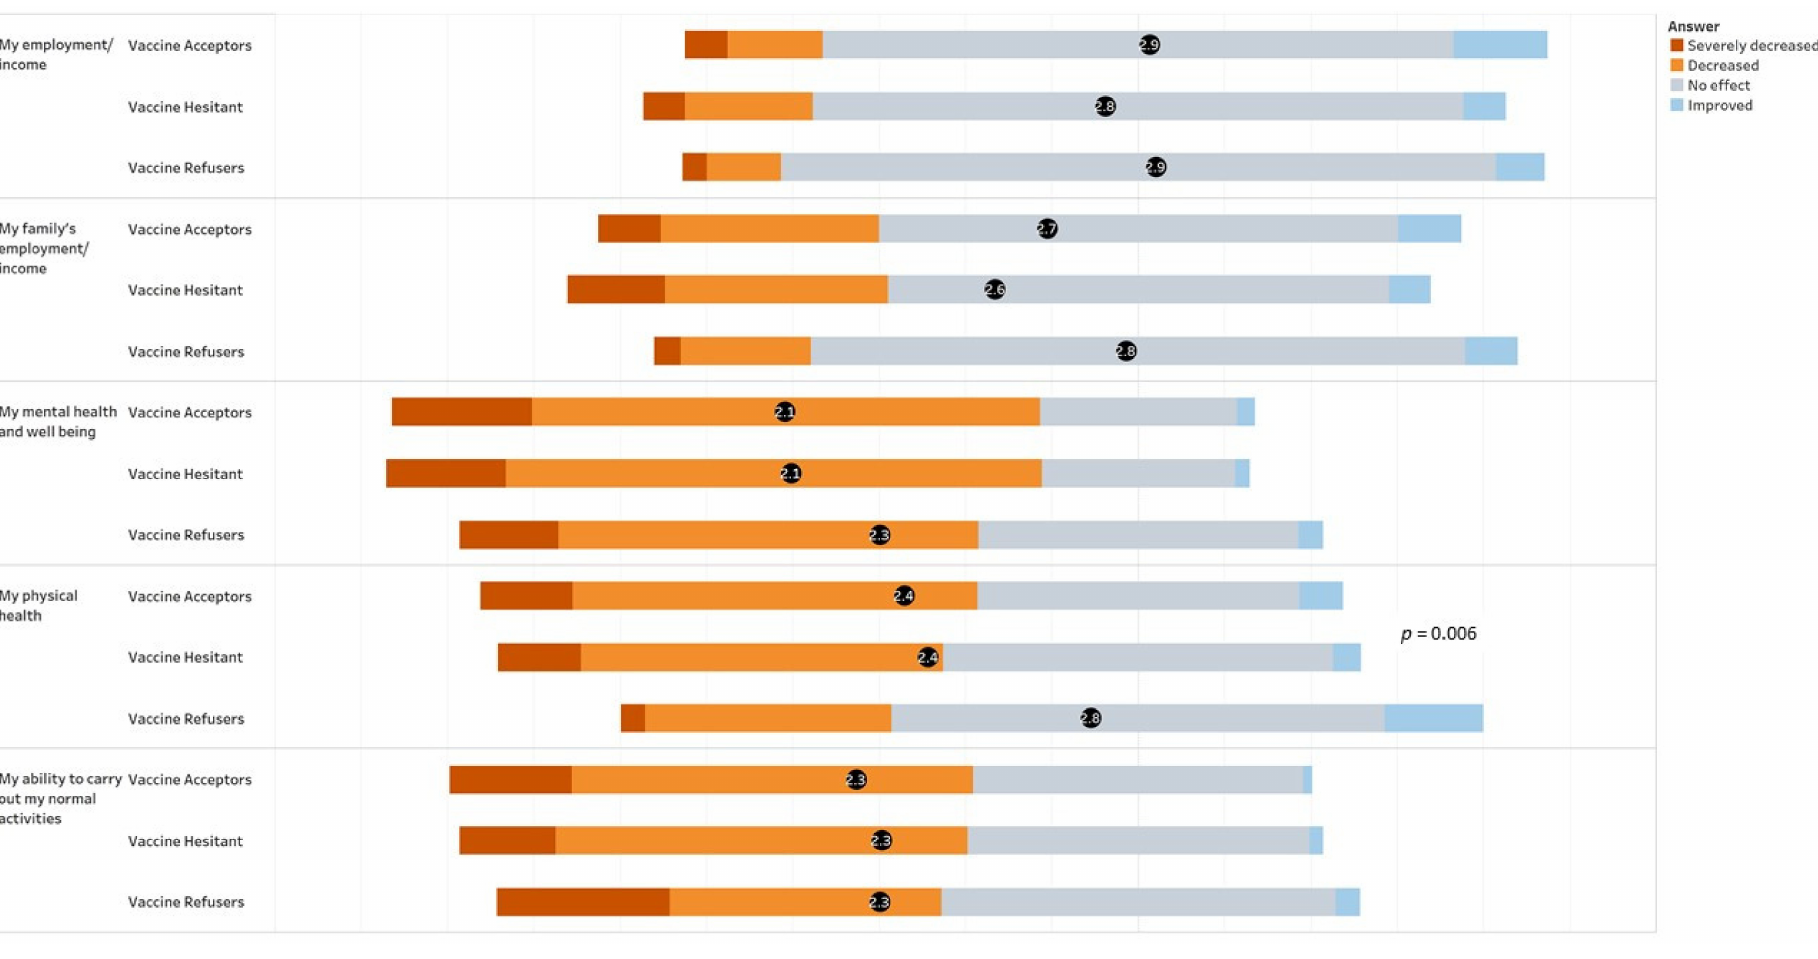
Figure 2. Reported effects of the COVID-19 pandemic on employment, income, health and normal activities, by